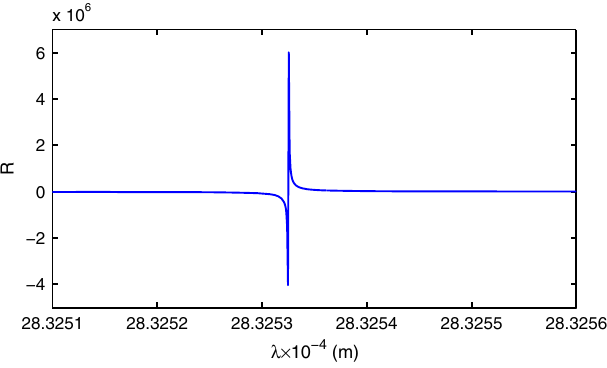
FIG. 3. Plot of R as a function of wavelength, as calculated using Eq. (5). Dielectric parameters used are taken from Table I, and β ¼ 0 . 33 , corresponding to 30 keV electron beam. The singularity in R appears at the resonant frequency of 0.1 THz.